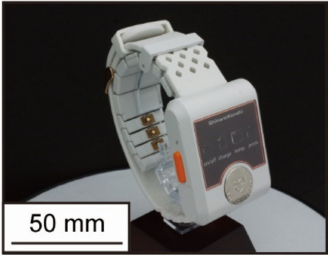
Figure 2. Wristwatch-type device being developed in our